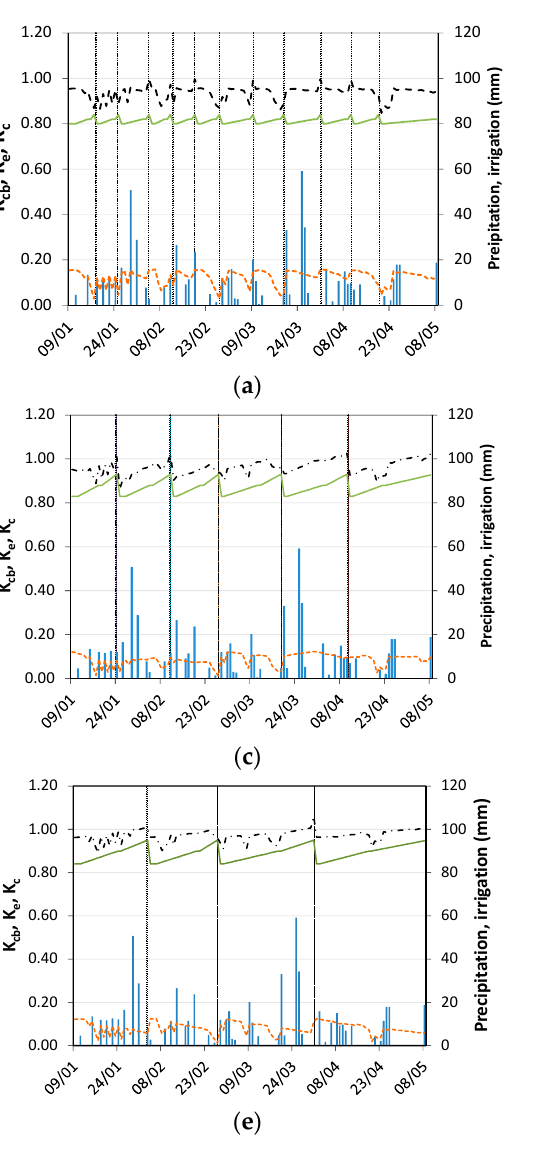
Figure 4. Basal crop coefficient (K cb, ── ), soil evaporation coefficient (K e, - - -) and average crop coefficient (K c, ─ - ─ ) curves of Tifton 85 bermudagrass and all cutting treatments with CGDD of 124 °C ( a , b ), 248 °C ( c , d ) and 372 °C ( e , f ) relative to the Summer–Autumn periods of 2016 ( a , c , e ) and 2017 ( b , d , f ).